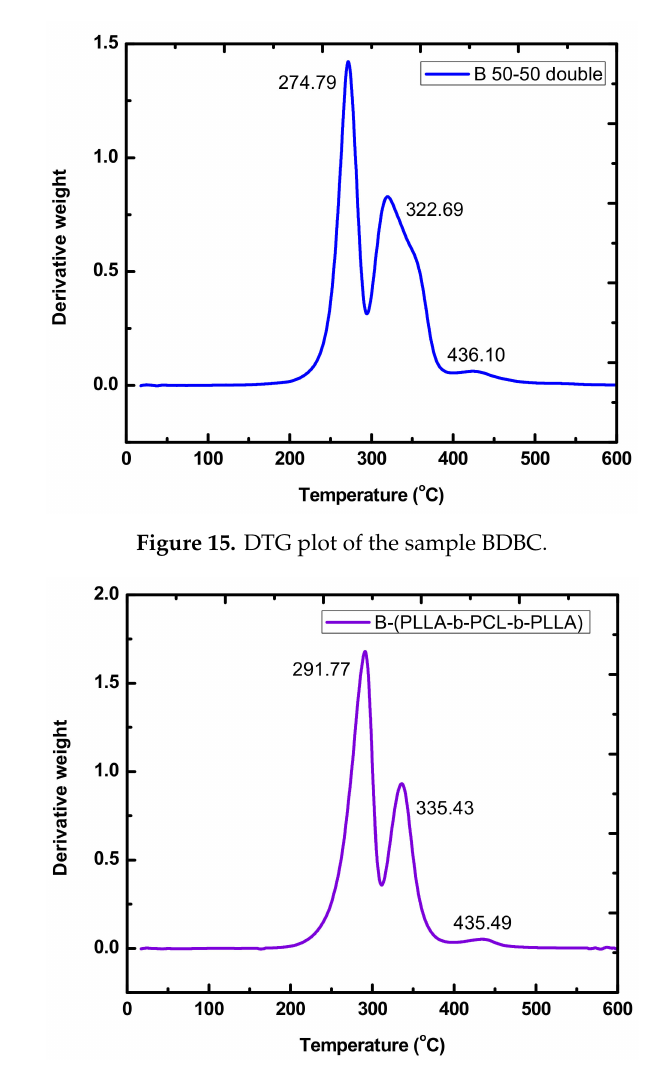
Figure 16. DTG plot of the sample